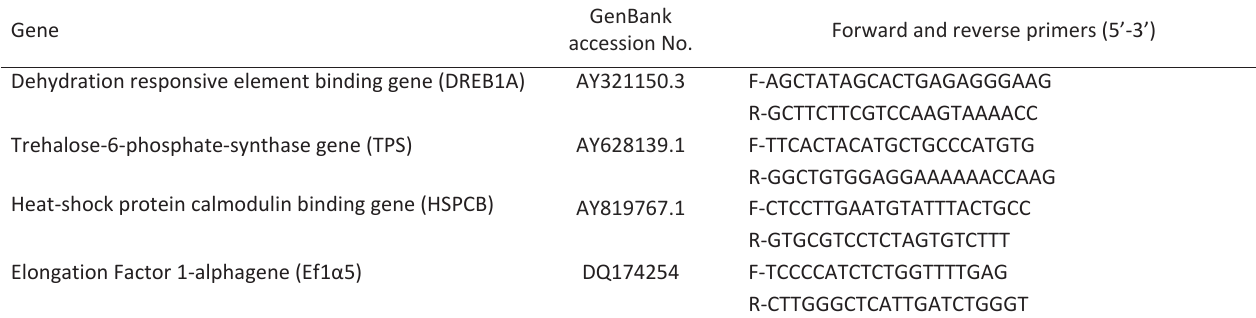
Table 1 - Target and reference genes accession numbers and primers sequences Gene